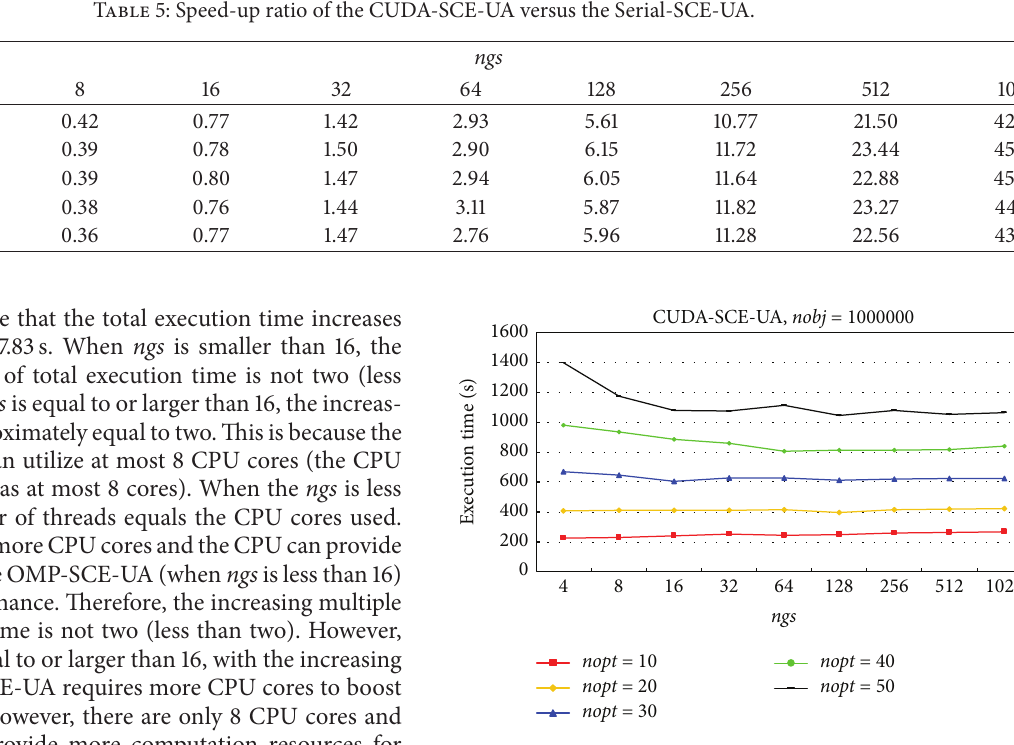
Figure 7: Total execution time (seconds) of the